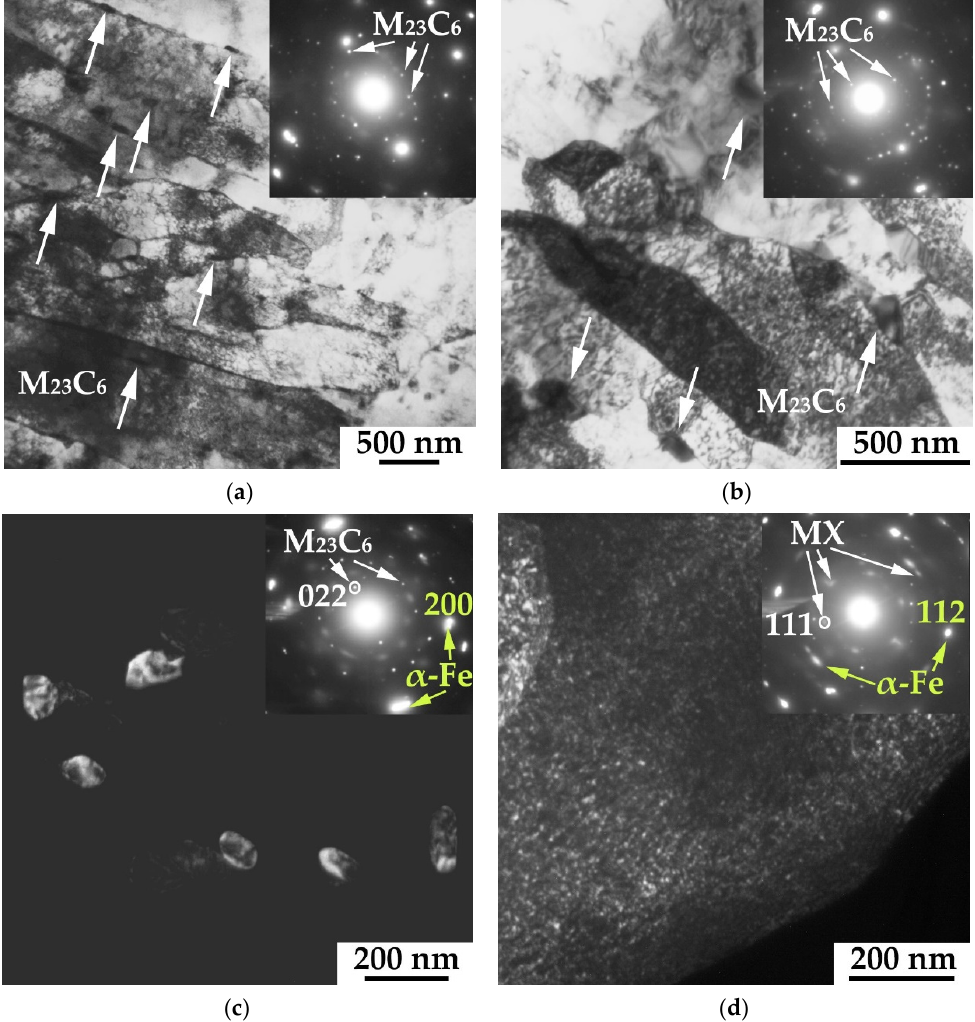
Figure 5. TEM images of steel microstructure after THT ( a ) and HTMT ( b – d ). ( a , b )—bright field images with the corresponding selected area electron diffraction (SAED) patterns, ( c , d )—dark-field images with the corresponding SAED patterns in reflections of M 23 C 6 and MX particles, respectively.